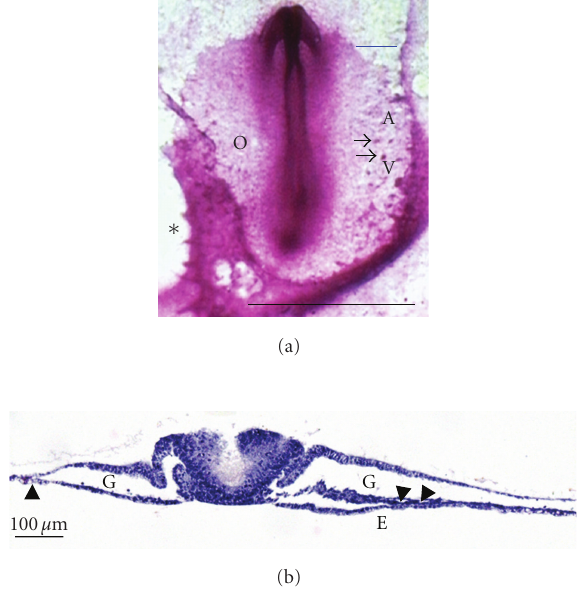
Figure 11: (a): In toto Unna stained (after fixation) blastoderm, operated as represented in Figure 10(a), after 29 hours of culture. An apparently normal embryo proper has developed symmetrically. At the operated side (O), only a few blood islands in a narrow area vasculosa are seen, and in the area vitellina an empty region ( ∗ ) is visible. In the unoperated side, a larger normal area vasculosa (AV) is seen with numerous blood islands (black arrows). Bar = 2 mm. (b): Section through the embryo of Figure 11(a) (plane of section is indicated in Figure 11(a) as a blue line). G, intraembryonic cavity closed at the operated side (indicated by the arrowhead directed upwards) contains no mesoblast. In the unoperated side, the intraembryonic cavity (G) extends far peripherally. It contains a mesoblast mantle which laterally forms blood islands close to the endoderm (E) which are domed by coelomic vesicles (indicated by 2 arrowheads directed downwards). Bar = 100 μ m.